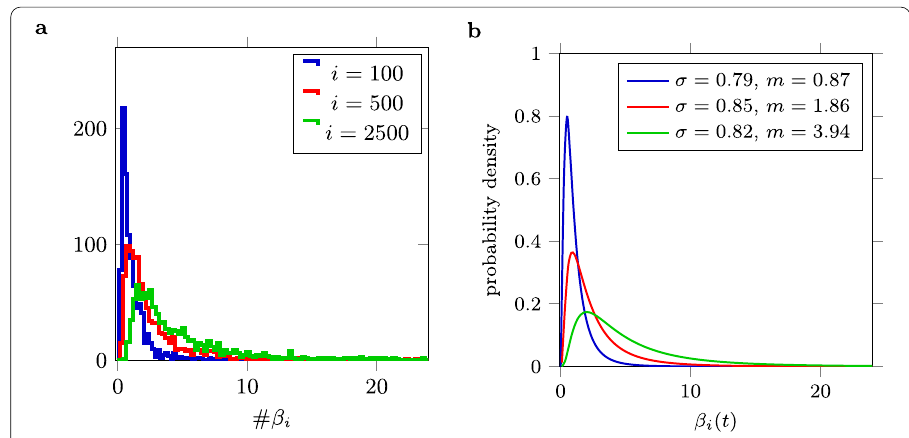
Fig. 9 a Empirical histograms for values of β i ( n ) for three nodes i = 100,500,2500 , obtained by simulating of 1000 BA networks of size n = 5000 ; b the density functions of log-normal distribution with parameters estimated for the corresponding samples of β i ( n ) , i =